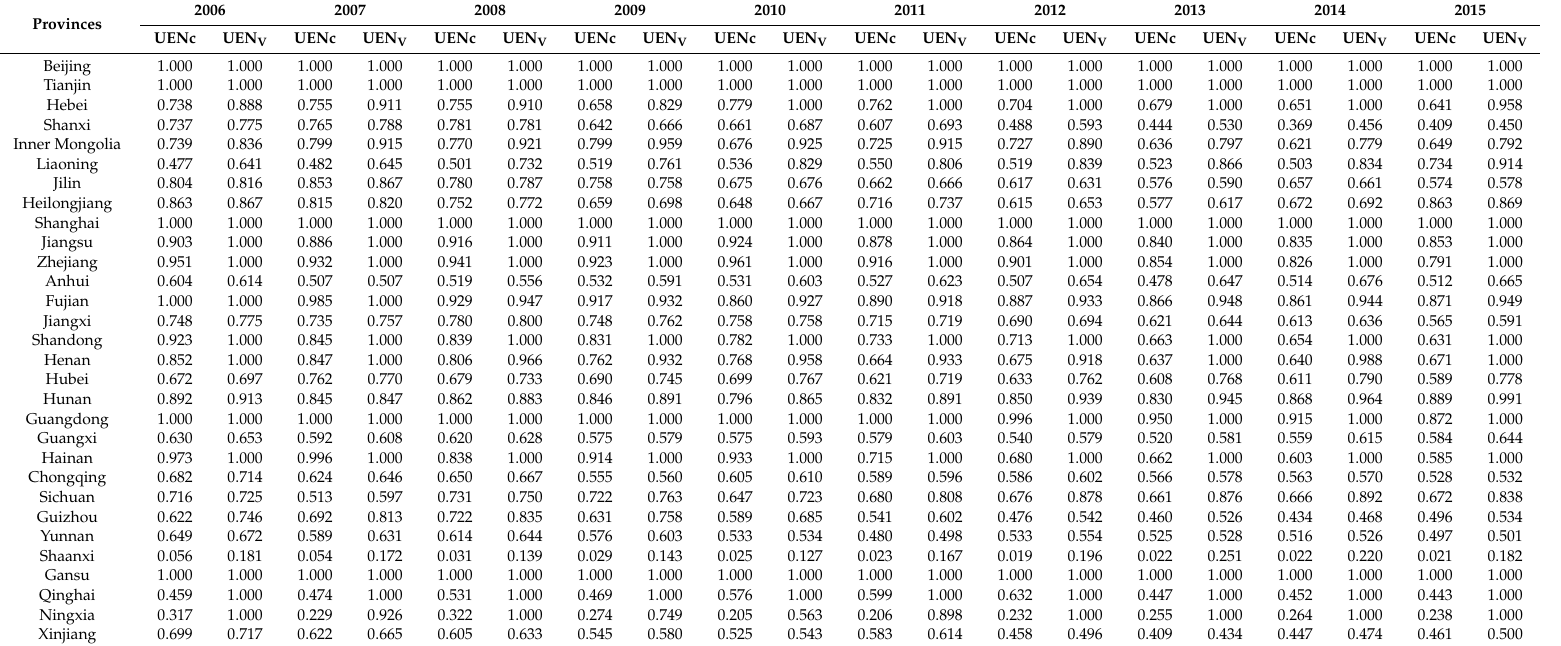
Table 2. Unified environmental e ffi ciency under natural disposability from 2006 to